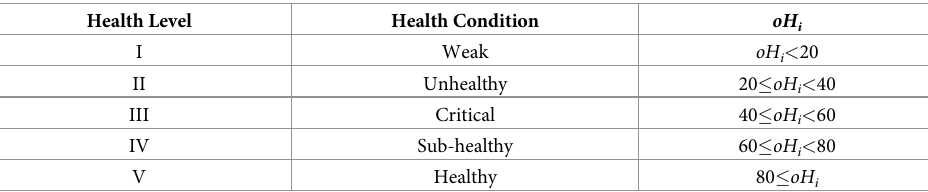
Table 2. Health of innovative ecological rainforest in pharmaceutical